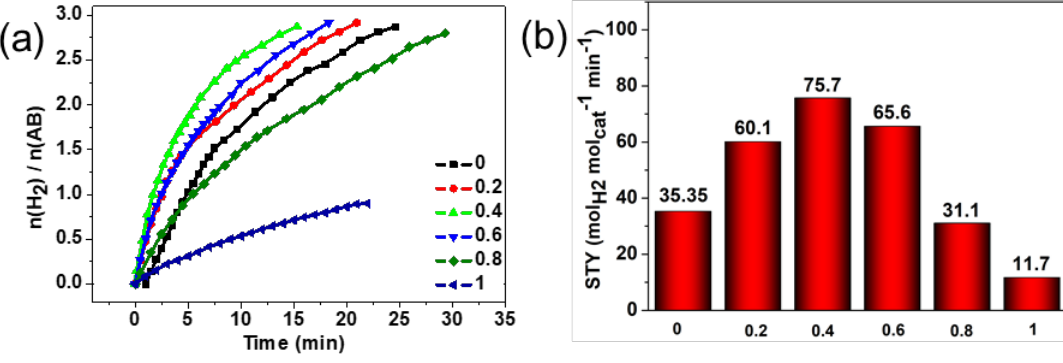
Figure 7. ( a ) Time vs. n (H 2 ) / n (AB) during the catalytic hydrolysis of AB with catalyst Cu x Co 1 – x MoO 4 /g-C 3 N 4 ; ( b ) STY values with x for Cu x Co 1 – x MoO 4 /g-C 3 N 4 .